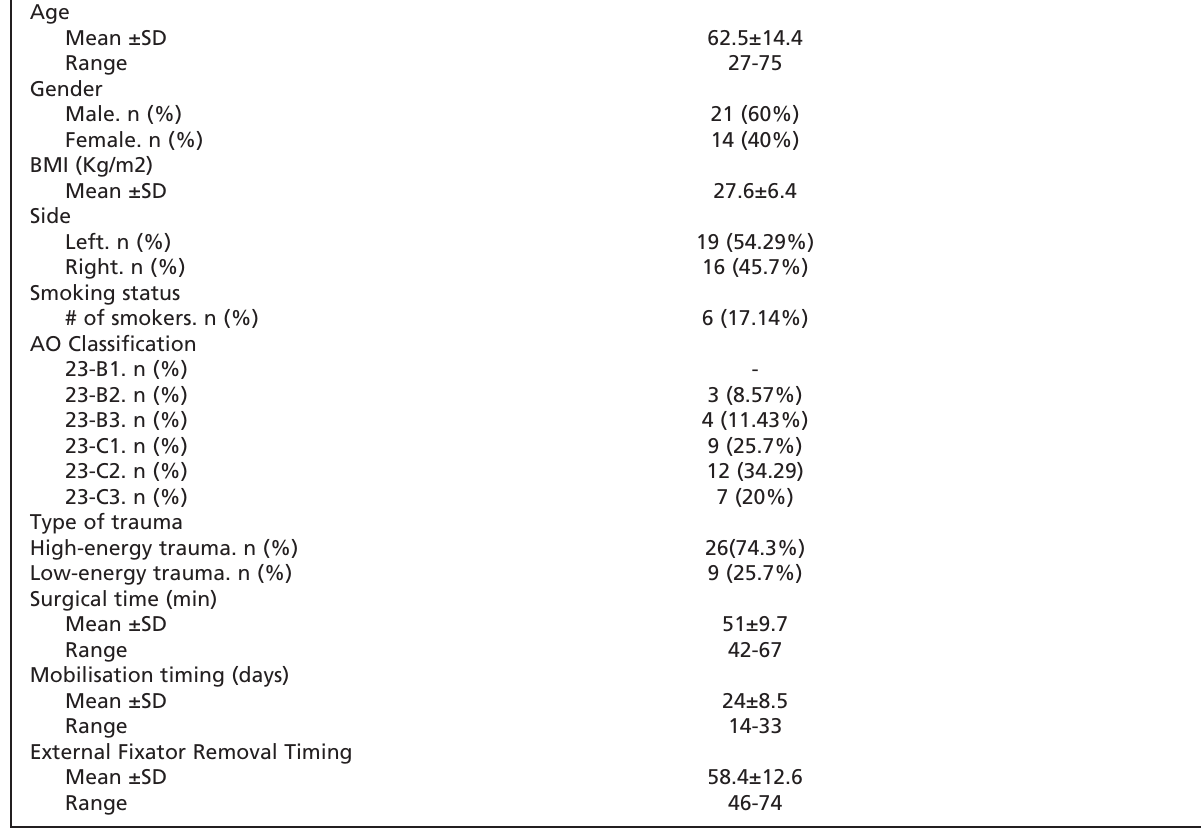
Main data of the study Table I: